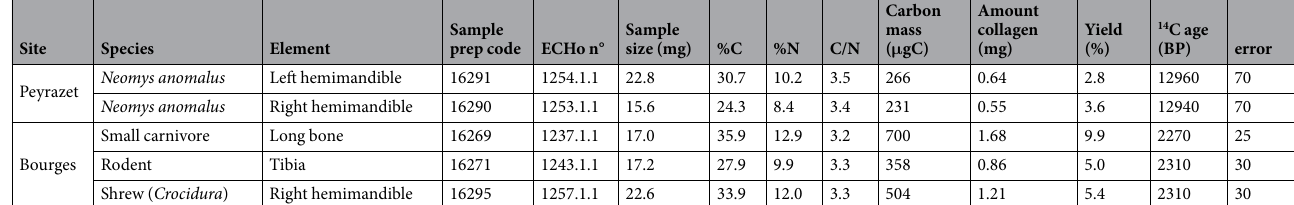
Table 2. Radiocarbon dating of archaeological samples. Samples characteristics, origin and zooarcheological identifications are addressed. Sample size, graphitization results and radiocarbon dates are also reported for each sample. Yield is estimated as the ratio (in percent) of the total amount of collagen recovered from the amount of initial bone used for extraction. The carbon mass corresponds to the amount of carbon detected following combustion in the Elemental Analyser and used to produce the graphite target. ECHo n° corresponds